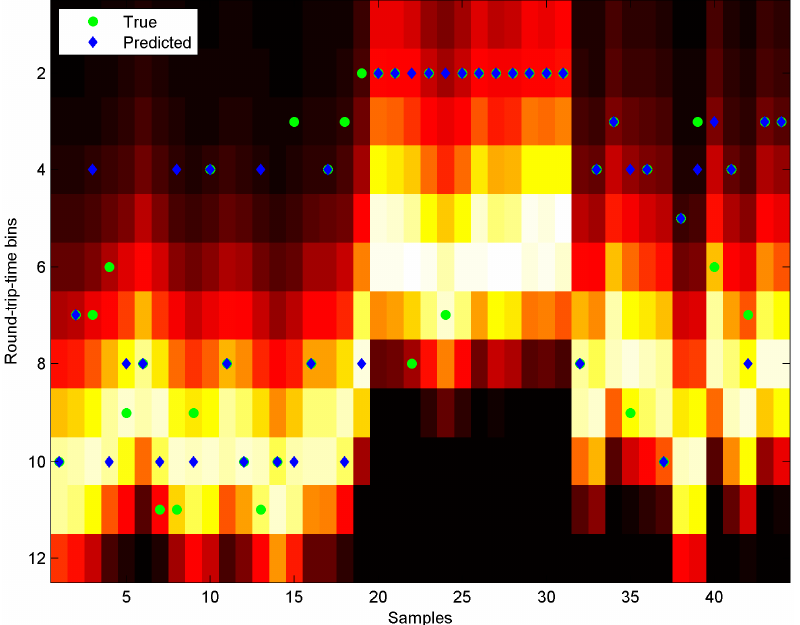
Figure 10. Prediction of network latency by neuro-fuzzy approach: the color of the background indicates the value returned by the fuzzy membership function assigned to each bin.